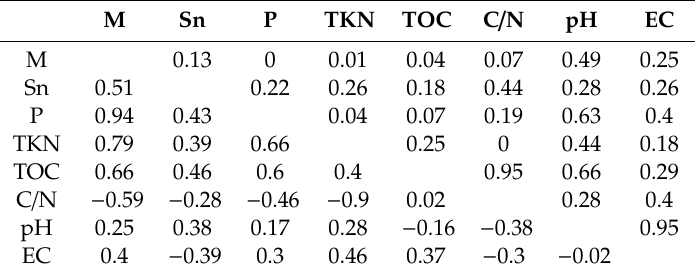
Table 3. Na soil parameters’ correlation coe ffi cients (left down) and corresponding p -values (right up); significant cases are